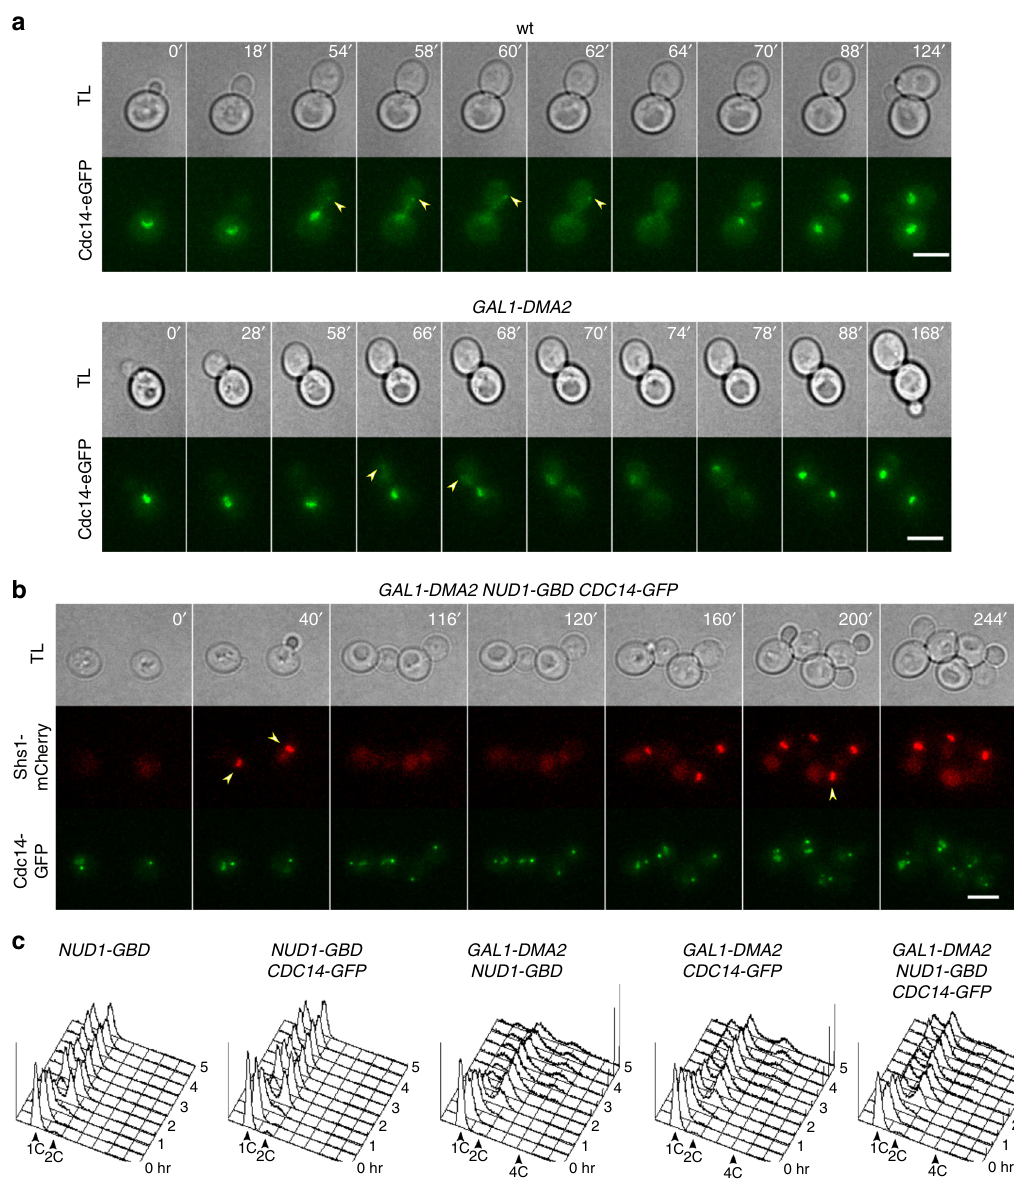
Fig. 7 Constitutive recruitment of Cdc14 to SPBs suppresses the cytokinetic defects of GAL1-DMA2 cells. a BUD4 and GAL1-DMA2 BUD4 cells expressing Cdc14-eGFP at endogenous levels were imaged by time lapse fl uorescence microscopy at 30 °C every 2 min. Scale bar: 5 μ m. b GAL1-DMA2 BUD4 cells expressing Nud1-GBD at endogenous levels and Cdc14-GFP from a centromeric plasmid were imaged at 30 °C every 4 min in selective medium ( − His containing raf fi nose and galactose) after being induced for ~90 min with galactose. TL transmitted light. Arrowheads indicate the appearance of Cdc14- eGFP at the bud-directed SPB in anaphase. Scale bar: 5 μ m. c Cells with the indicated genotypes (all BUD4 ) were grown in selective medium ( − His containing raf fi nose) at 25 °C, arrested in G1 with alpha factor, induced with galactose 30 min before the release and fi nally released in YEPRG at 30 °C. At the indicated times cells were collected for FACS analysis of DNA contents. FACS data were plotted after gating out the debris as illustrated